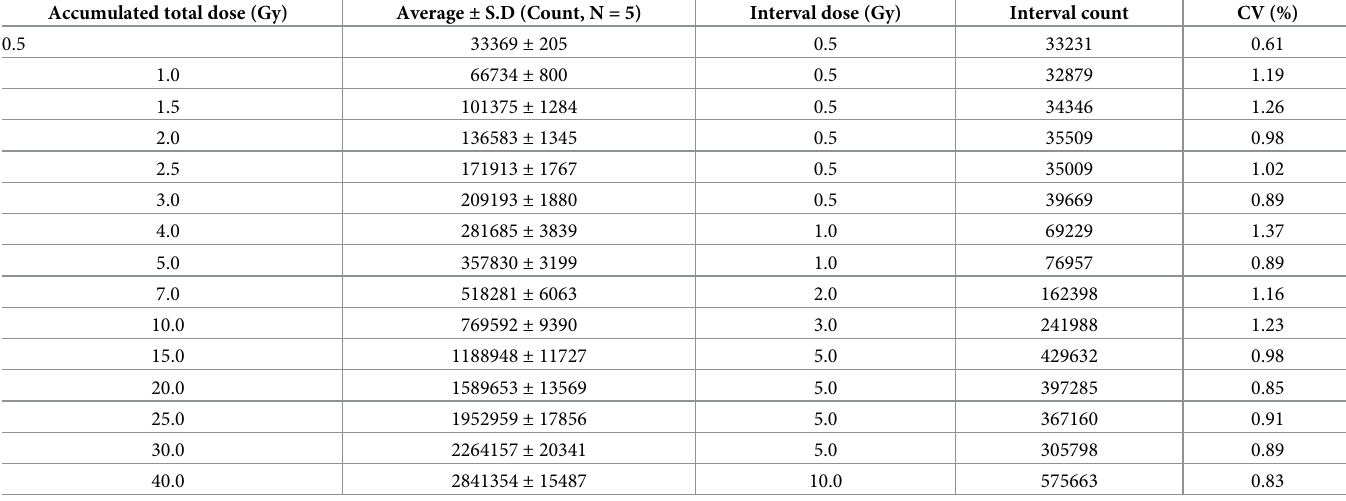
Table 1. Relationship between dose and count value used to determine the dose-response curve (“Average” and “SD” indicate the average and standard deviation of reference dosimeters (N = 5), respectively, and “Interval dose” means a dose added between the doses; CV means variation of measured count value in each dose with the reference